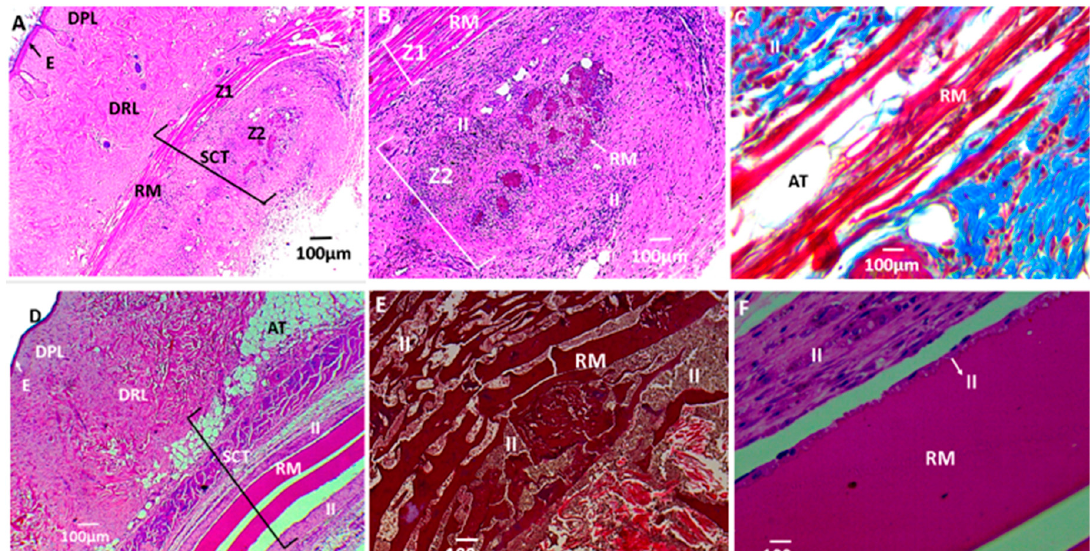
Figure 13. Histological analysis of experimental samples: ( A – C ) formulation F4 (CS/PVA/GO 14.25:85:0.75) and ( D – F ) formulation F5 (CS/PVA/GO 29:70:1). All the ratios are wt %. E: Epidermis; DPL: Dermis papillary layer; DRL: Dermis reticular layer; BV: Blood vessels; AT: Adipose tissue; H: Hypodermis; MT: Muscular tissue; SCT: Subcutaneous cellular tissue; RM: Remnant material; II: Inflammatory infiltrate; Z1: Zone 1; Z2: Zone 2. ( A ) 4 × ; ( B ) 10 × ; ( C ) 40 × ; ( D ) 4 × ; ( E ) 10 × ; ( F ) 40 × .